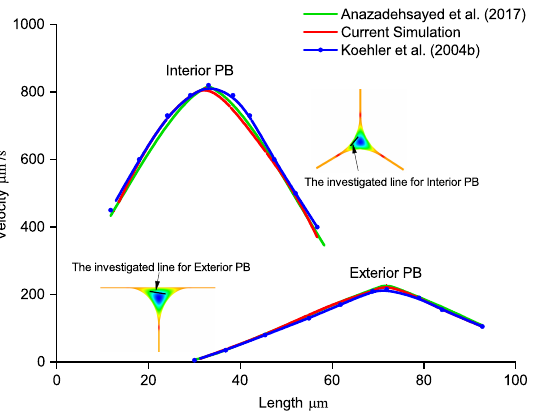
Figure 4. PB velocity validations in the interior and exterior of the foam. The bold line in both the exterior and interior cross-sections represent the specific lengths of the PB (perpendicular to gravitation), where the flow velocities were calculated by Koehler et. al [37,38]. The velocities were compared to those in previous studies and they corresponded.